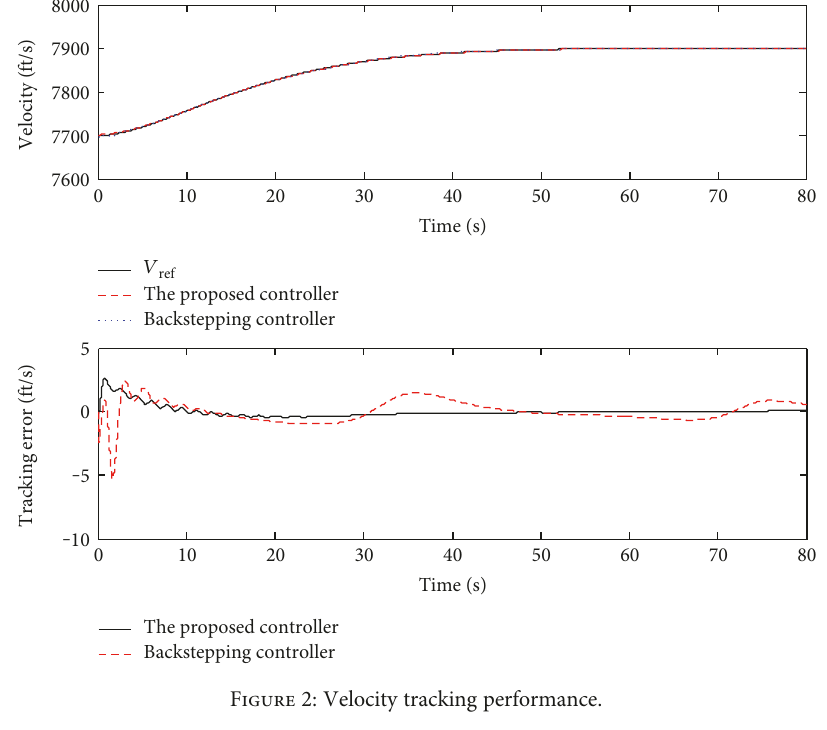
Figure 2: Velocity tracking performance.